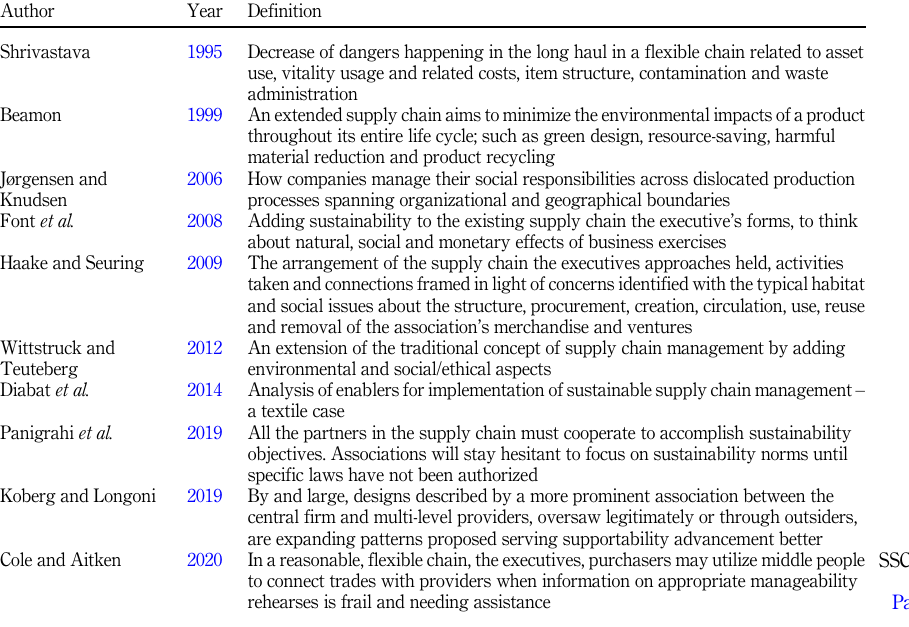
Table 1. SSCM definitions in the literature (source: Panigrahi et al. ,